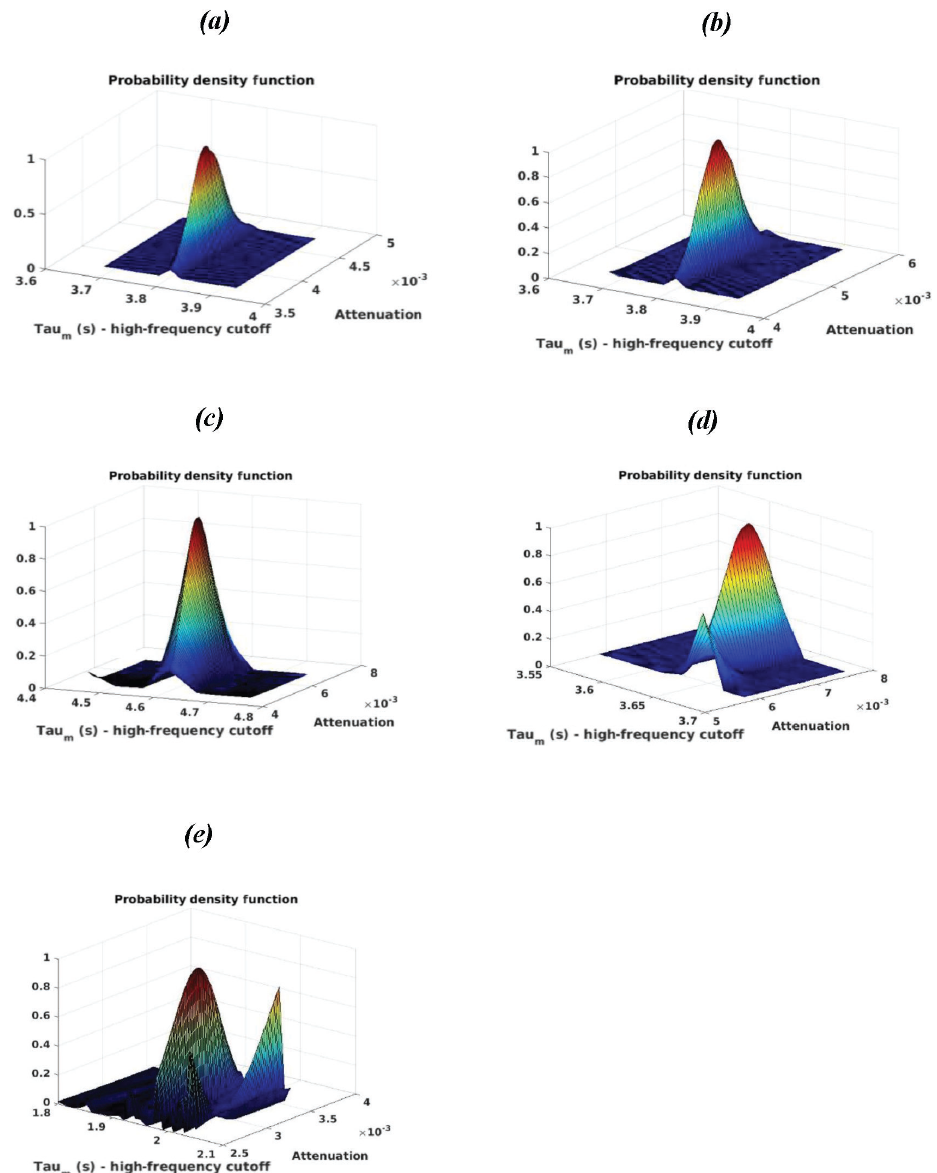
Figure 5. Gaussian probability density function constructed with the least squares norm difference between predictions and simulated obser- vations for (a) MODEL 1, (b) MODEL 2, (c) MODEL 3, (d) MODEL 4 and (e) MODEL